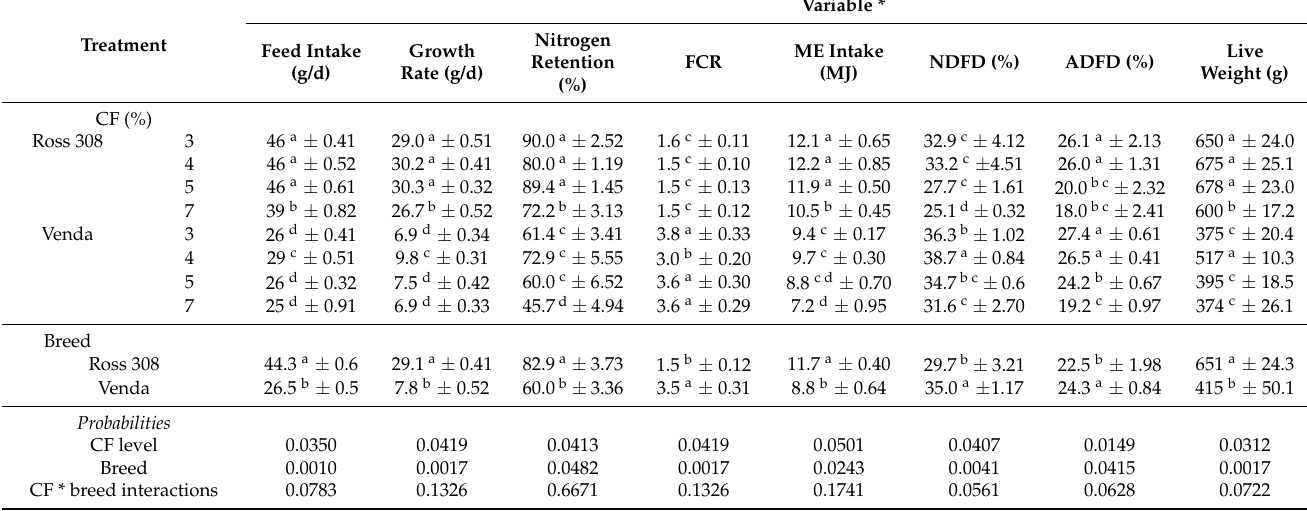
Table 3. The effect of dietary crude fiber level on the production performance of the male Ross 308 broiler and Venda chickens aged 1 to 21 days.